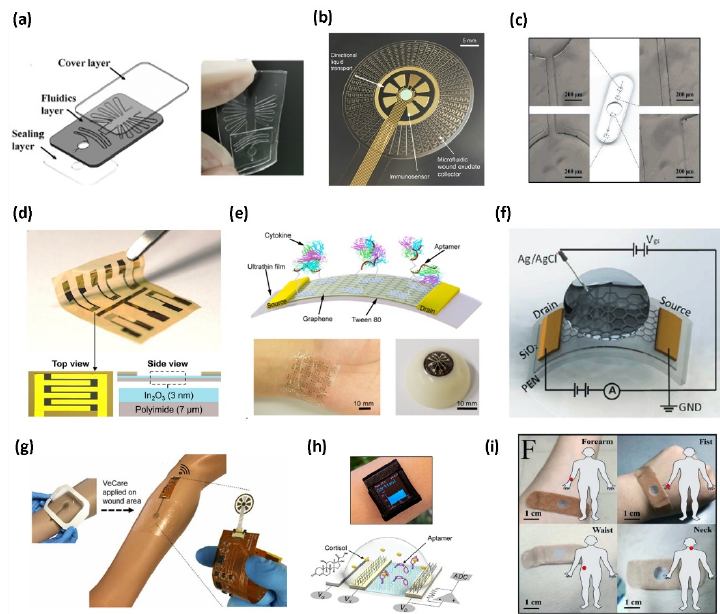
Figure 2. Different approaches of creating the three-layer structure of a wearable biosensor. The microfluidic layer can be embedded in a broad range of polymers. ( a ) Microfluidics was patterned